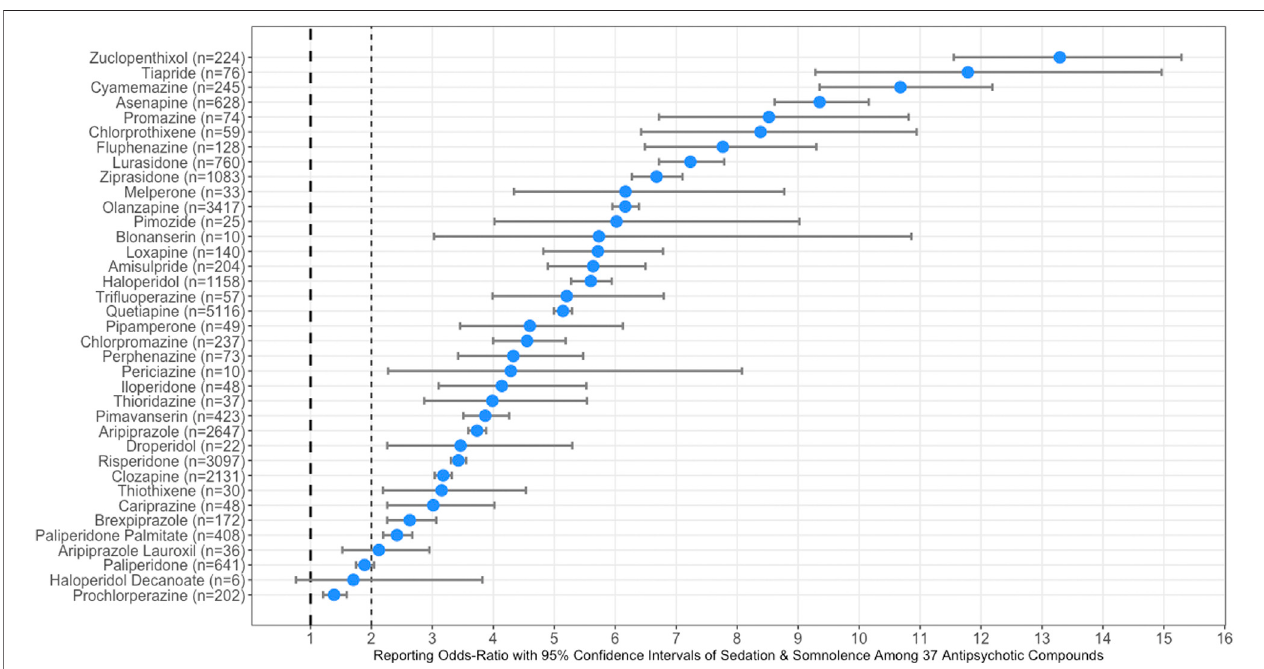
FIGURE 1 | Forest plots illustrating reporting odds-ratios (RORs) with 95% con fi dence intervals (CI) of sedation and somnolence among all thirty-seven typical an atypical antipsychotic compounds. The dashed line at one represents the reference point for statistical signi fi cance of sedation and somnolence.